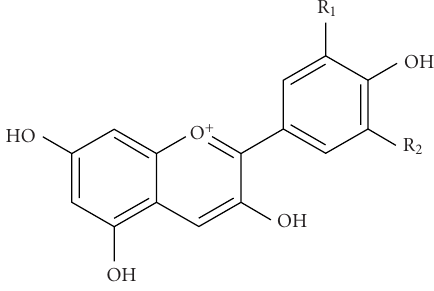
Figure 1. Structural formula of anthocyanidins. Cyanidin, R 1 = OH, R 2 = H; delphinidin, R 1 = R 2 = OH; peonidin, R 1 = OCH 3 , R 2 = H; petunidin, R 1 = OCH 3 , R 2 = OH; malvidin, R 1 = R 2 = OCH 3